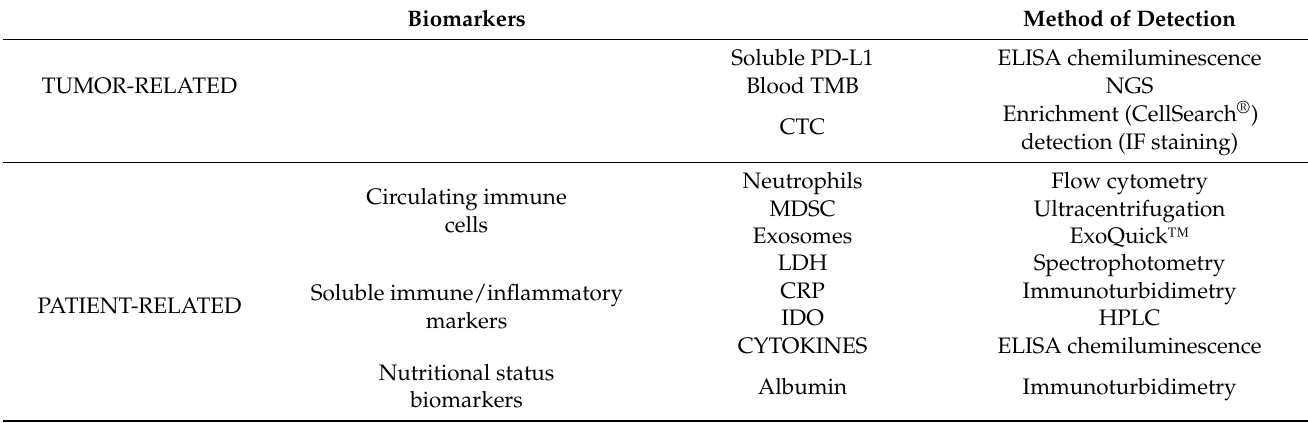
Table 1. Potential blood biomarkers of response to ICIs in NSCLC patients. TMB: tumor mutational burden. CTC: circulating tumor cells. MDSC: myeloid-derived suppressive cells. IDO: